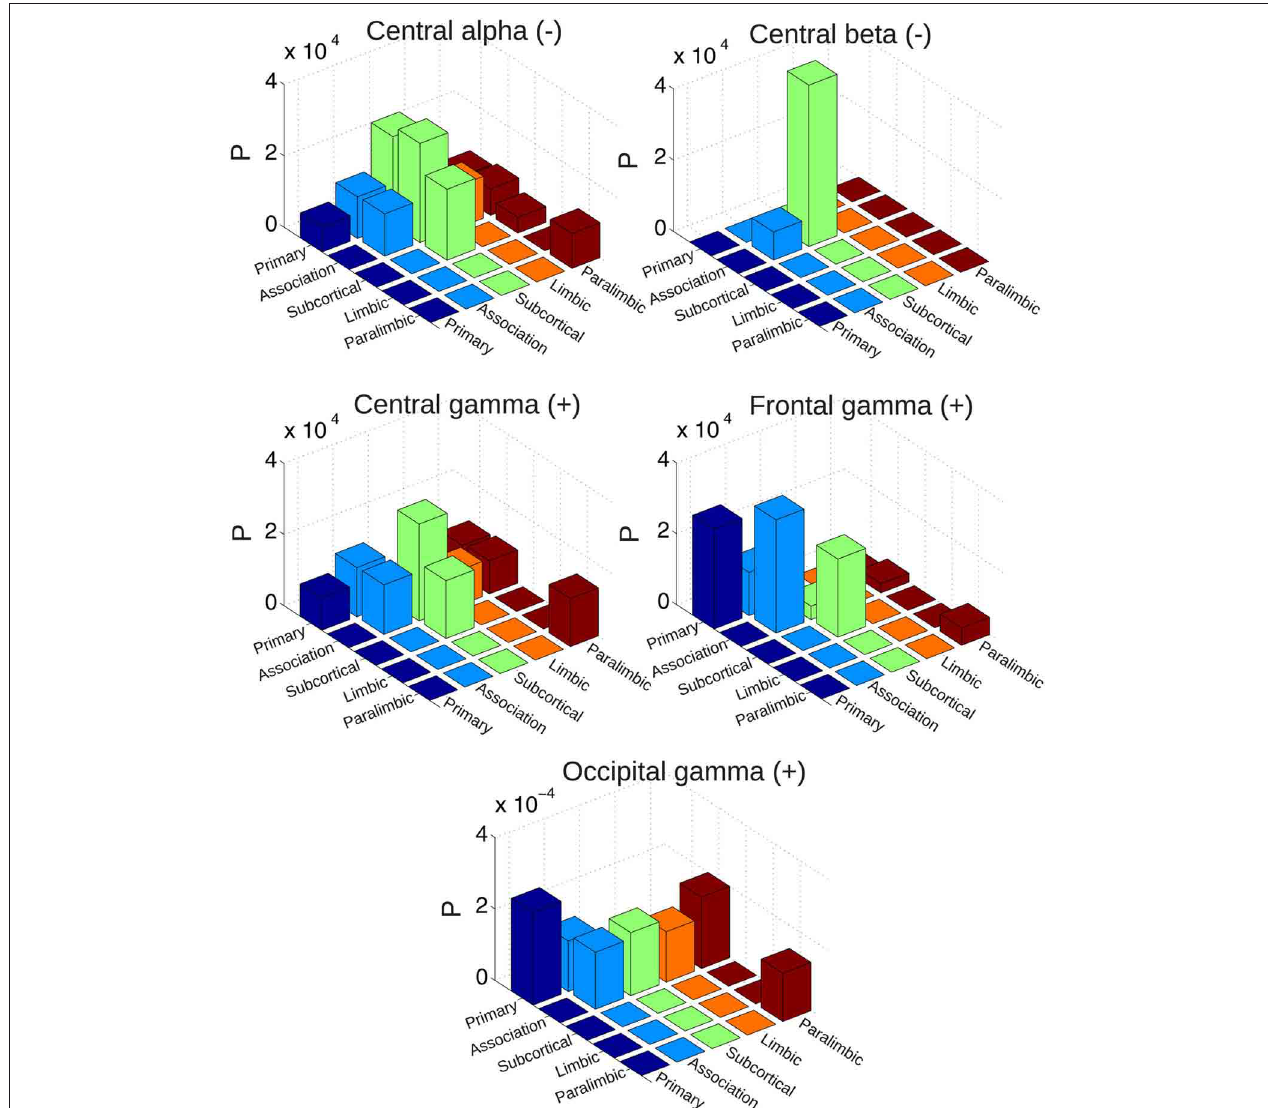
FIGURE 8 | Probability of finding connections between different systems (sensory, association, subcortical, limbic, and paralimbic) which correlate either positively or negatively with spontaneous EEG power